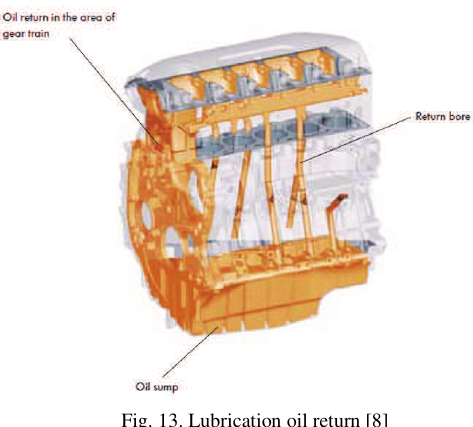
Fig. 13. Lubrication oil return [8]